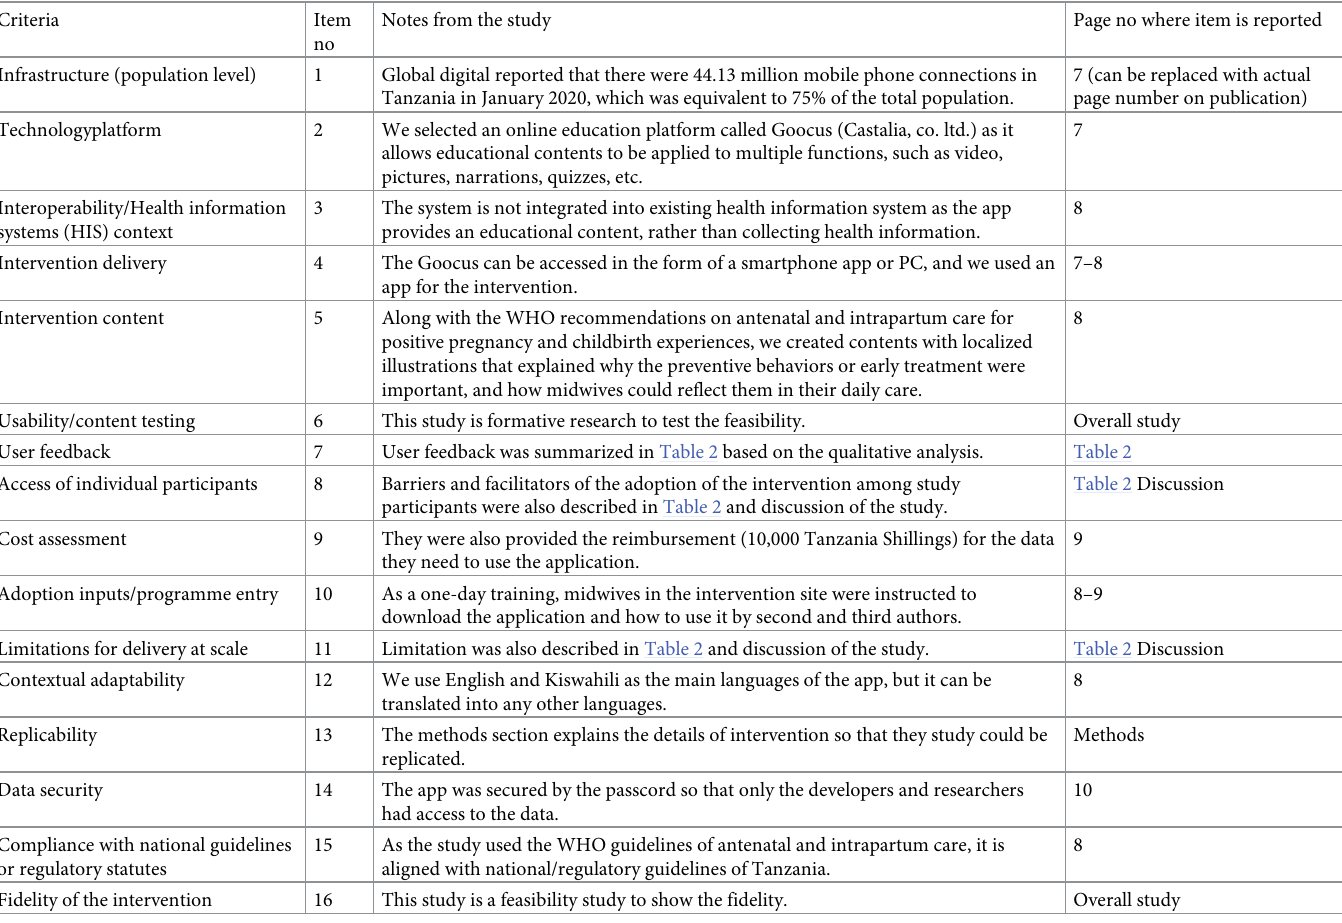
Table 1. Notes based on the mHealth evidence reporting and assessment guideline by